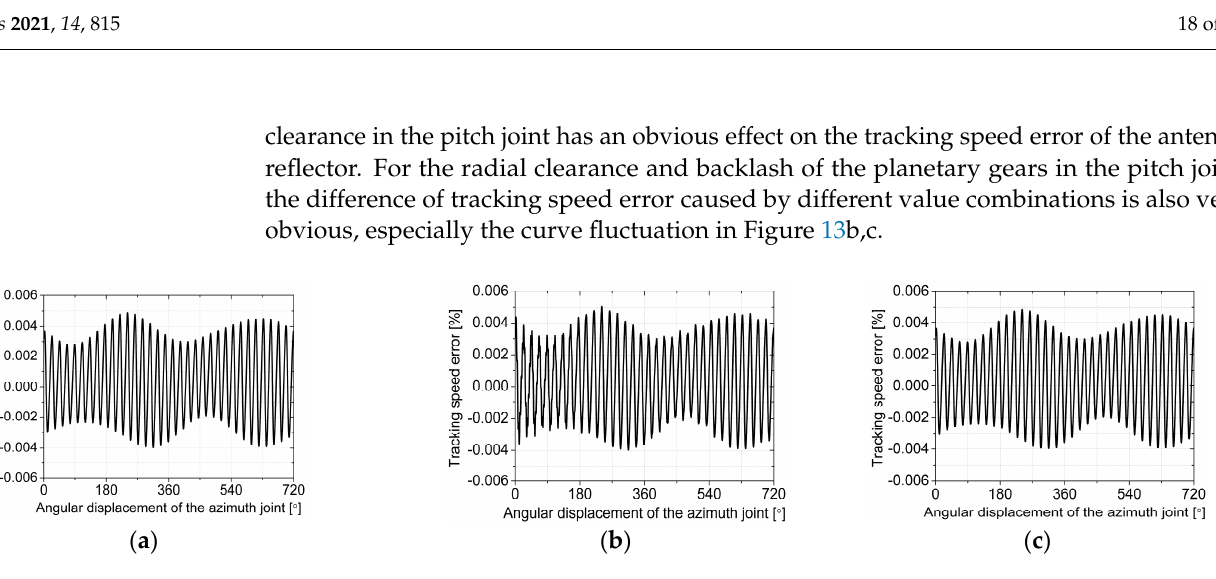
Figure 12. Tracking speed error of antenna reflector caused by different clearance size of planetary gear in azimuth joint: